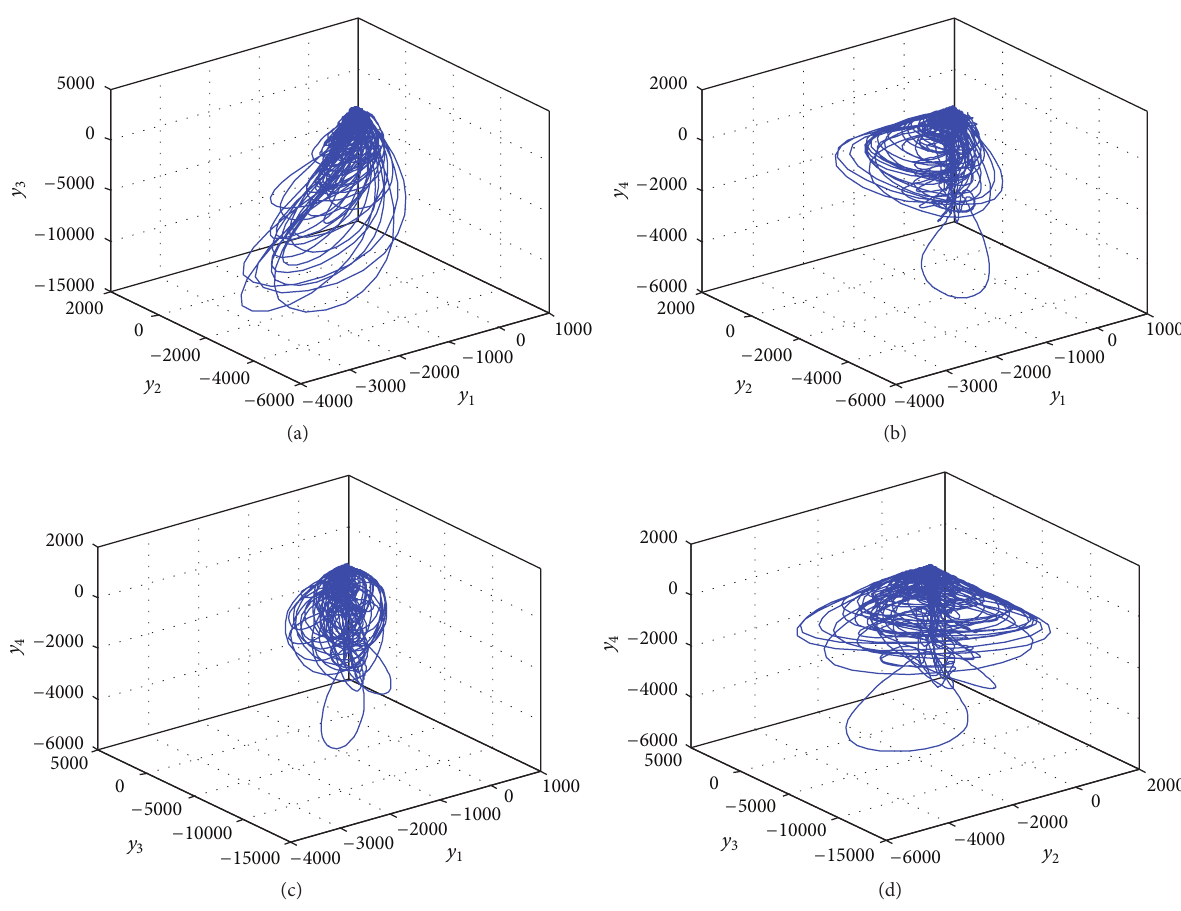
Figure 8: Projections of the phase portrait for chaotic system (3) of Case